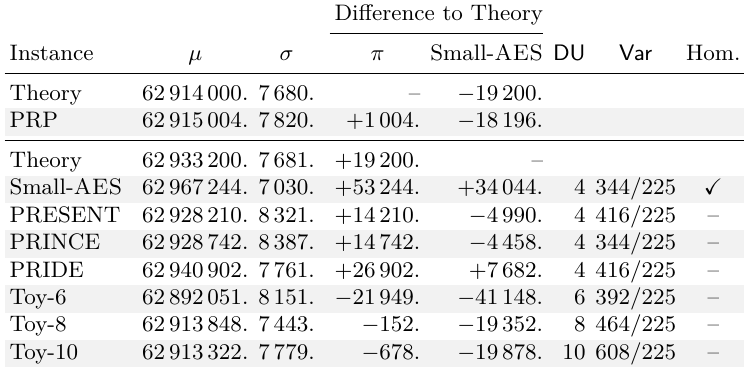
Table 10: Results of the four-round distinguisher on Small- AES with different S-boxes and 100 random keys. Speck-64-96 has been used as PRP . Difference = to the theoretical value; DP = the maximal number of pairs for a differential through the S-box; Var = variance; hom. = homogeneous; (cid:88) /– =